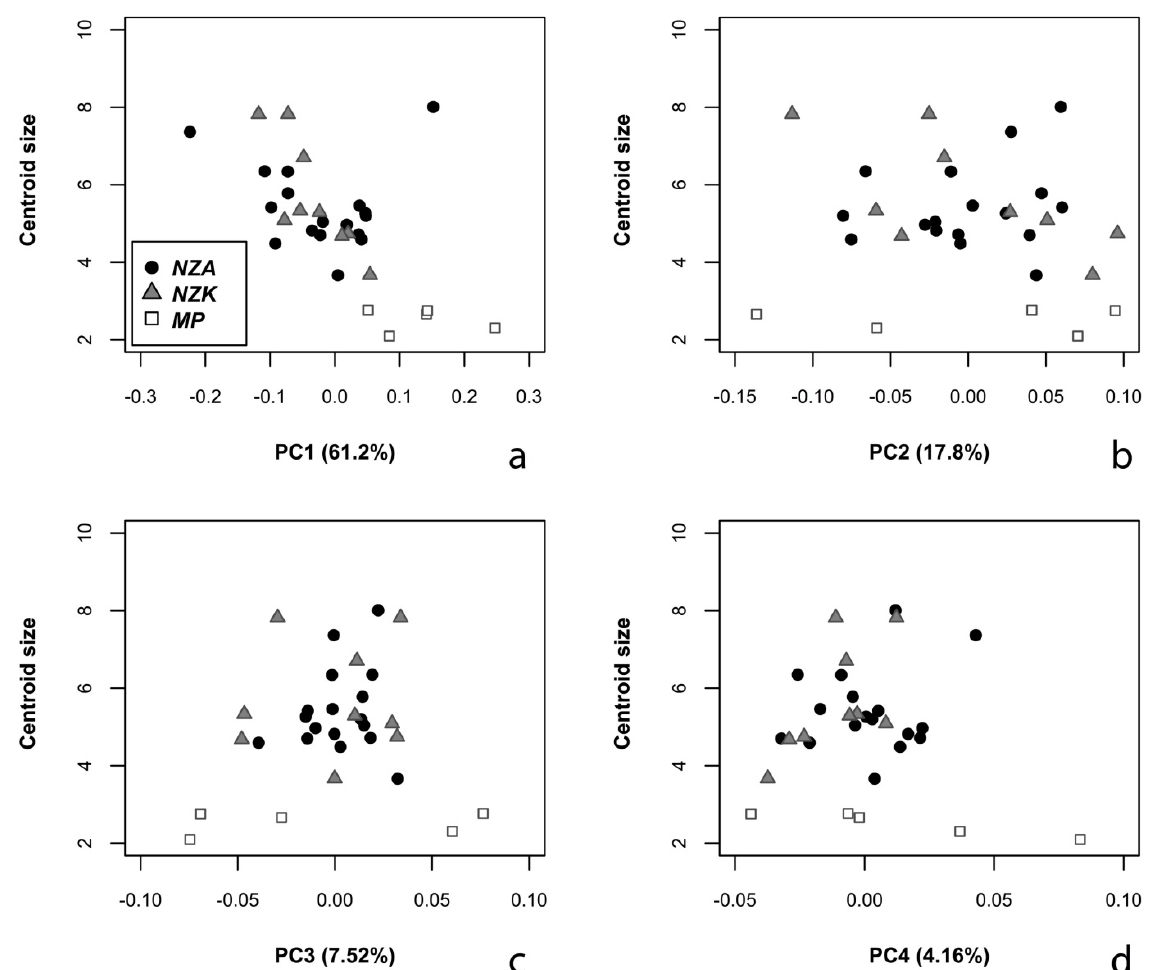
Figure 19. Bivariate plots of the first four PC scores (based on the EFA coefficients) and the centroid size of the Lupemban points. Symbols represent sites (circles: NZA, triangles: NZK, squares: MP). Table 11. MANOVAs results for the Lupemban points assemblages, realised on EFA coefficient (PC1-13 scores), five indices, and LSR (PC1-2). Significant values are shown in bold. EFA Log Shape Ratio 5